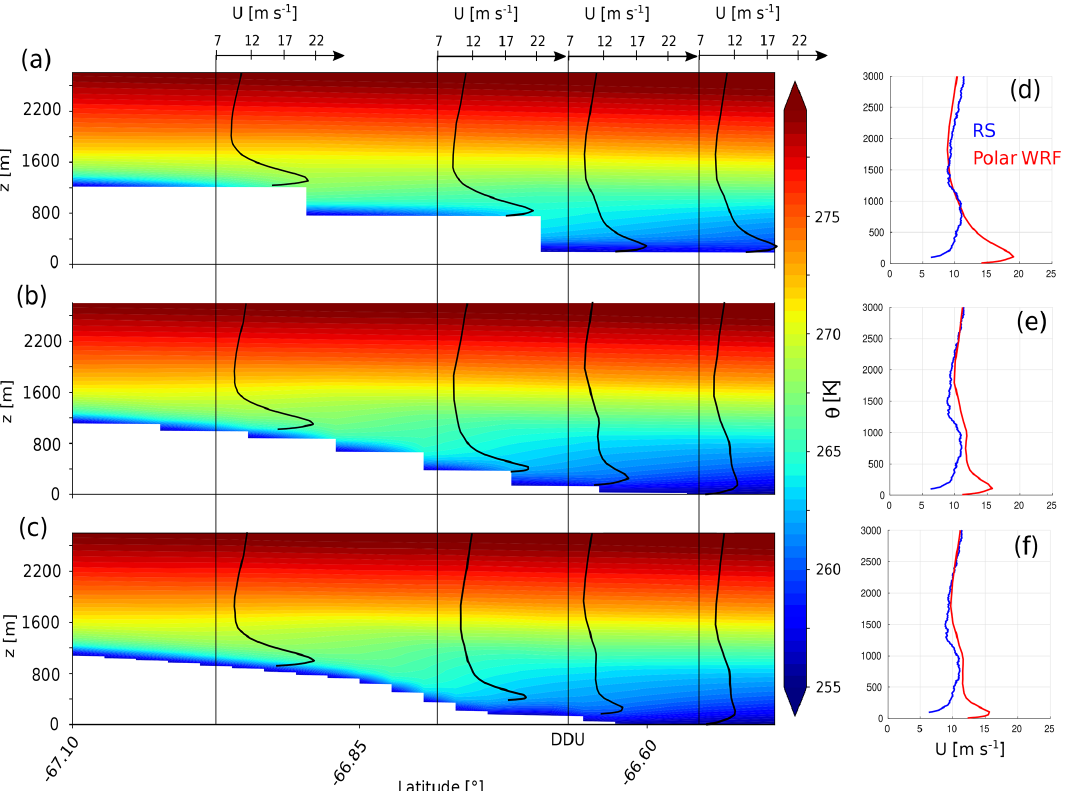
Figure 13. (a–c) Meridional cross section (longitude: 140.00 ◦ ) of the June–July–August mean potential temperature around DDU in Polar WRF simulations at 27km resolution (a) , 9km resolution (b) and 3km resolution (c) . June–July–August mean vertical profiles of the wind speed at four locations along a continent–ocean transect are also plotted. (d–f) Mean JJA vertical profiles of wind speed at the DDU station. Blue lines refers to the 2010–2017 radiosonde (RS) data set, red lines to Polar WRF simulations at 27km resolution (d) , 9km resolution (e) and 3km resolution (f) . In panels (e) and (f) , Polar WRF vertical profiles are computed following the method in Appendix C for more consistent comparison with radiosonde